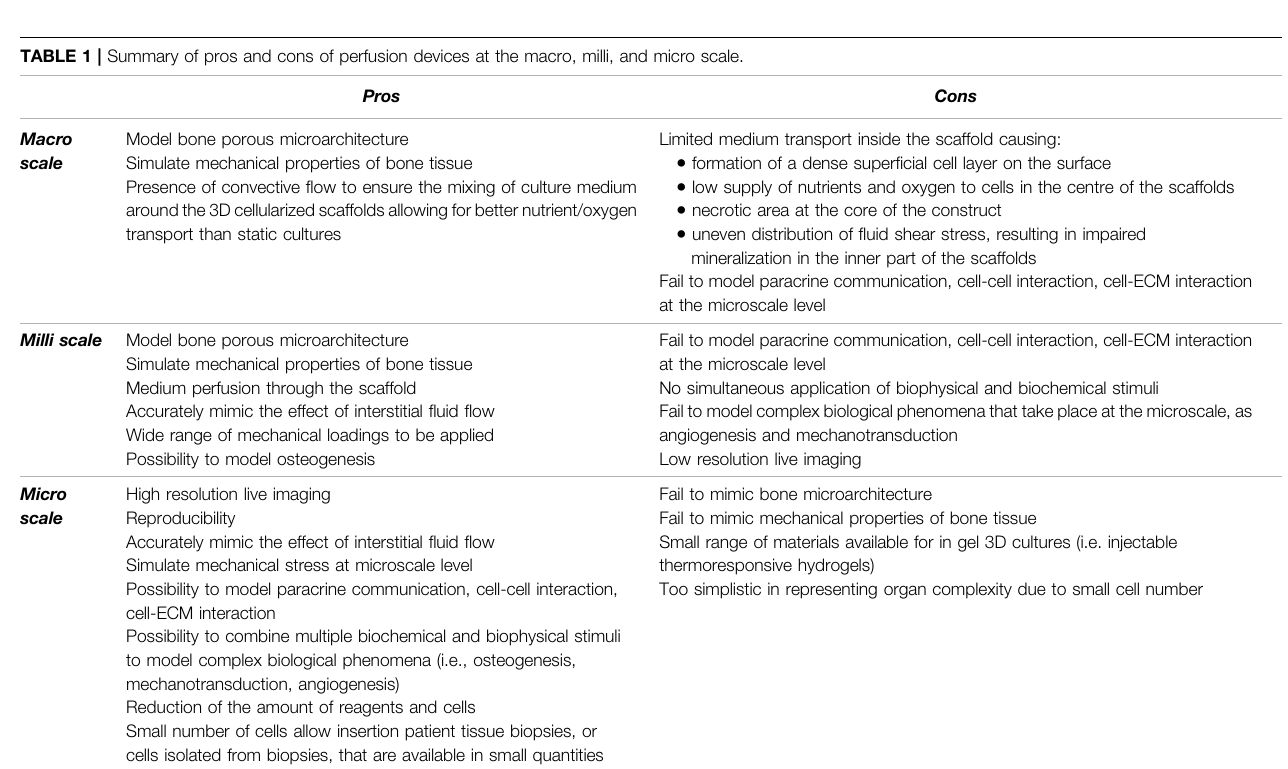
FIGURE 2 | Schematic representation of a micro fl uidic device: micrometric channels exposed to multiple biochemical (e.g., chemical and oxygen gradient), biological (e.g., multicellular types, vasculature) and biophysical stimuli (e.g., shear stress, deformation).